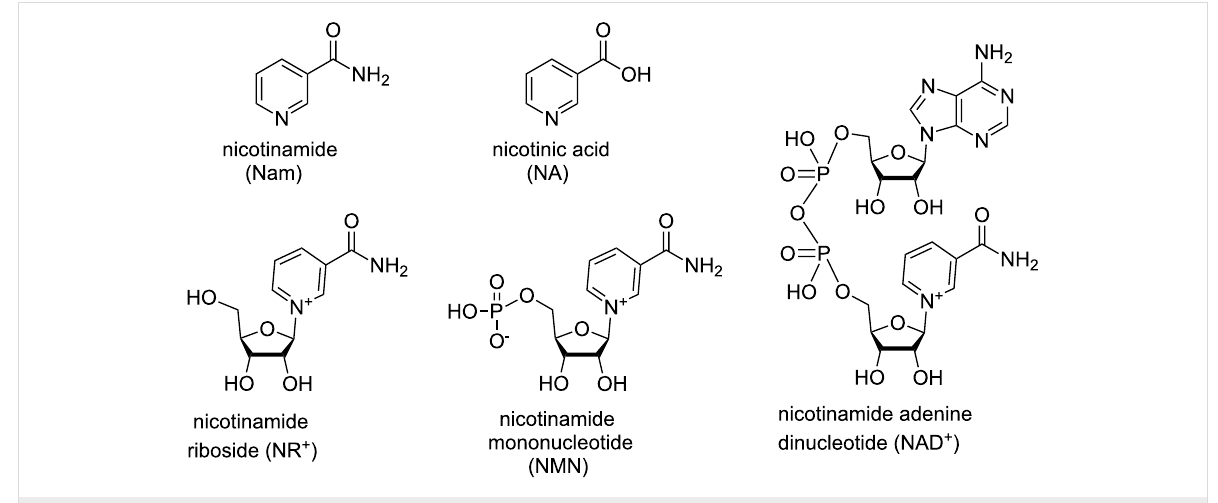
Figure 1: Structural formulas of Nam, NA, NR + , NMN, and NAD + .